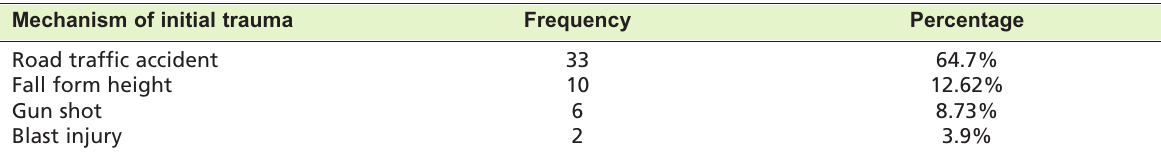
Mechanism of initial injury Table I: